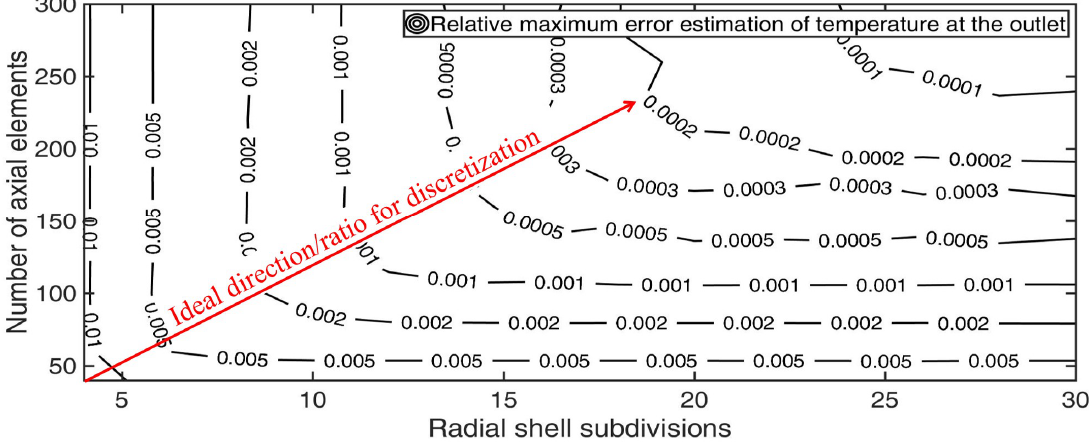
Figure 17. Estimations of maximal relative errors at the outlet of the pipe (Case 1), where the red arrow signifies the ideal direction for discretization.